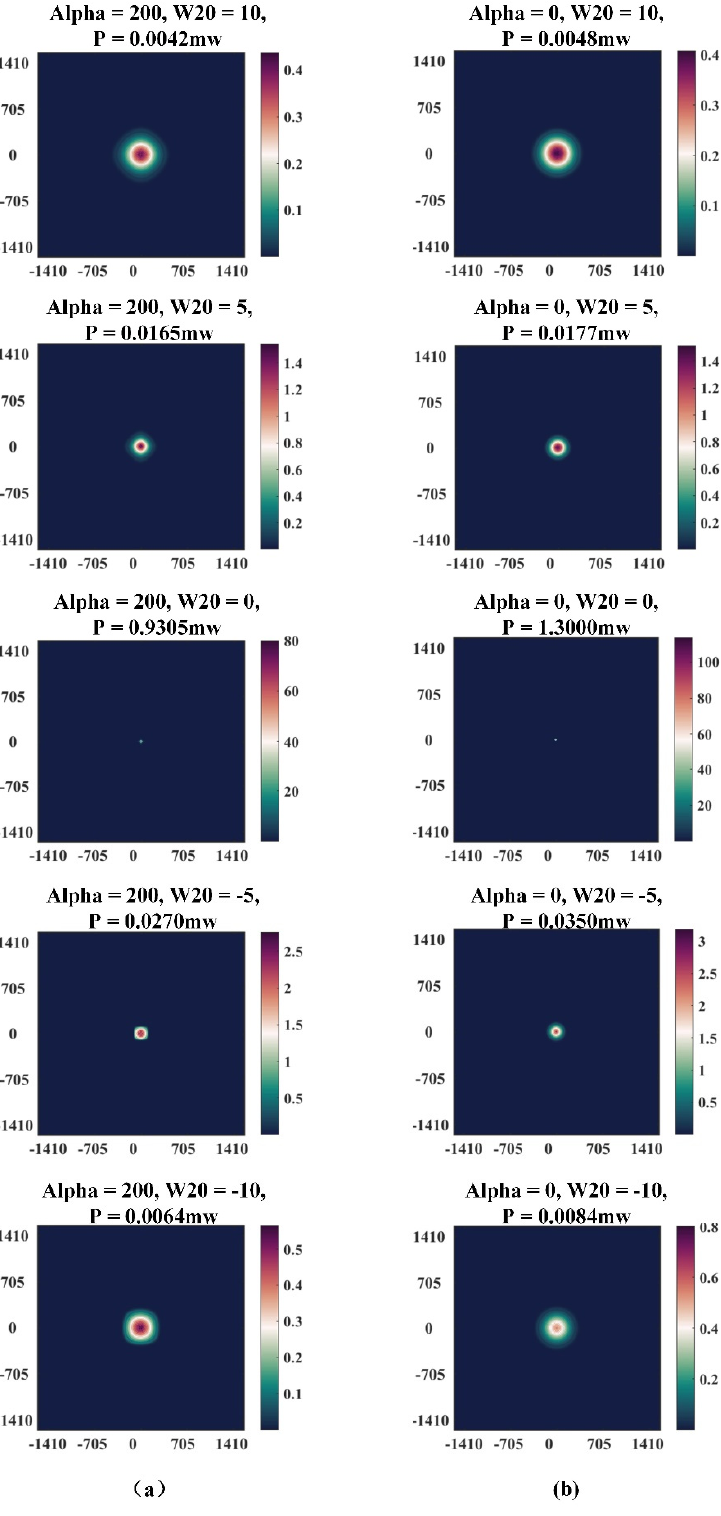
Figure 4. The cat-eye echo at a 20 m distance of ( a ) the conventional imaging system and ( b ) wavefront coded imaging system along with the corresponding echo-detector receiving power.